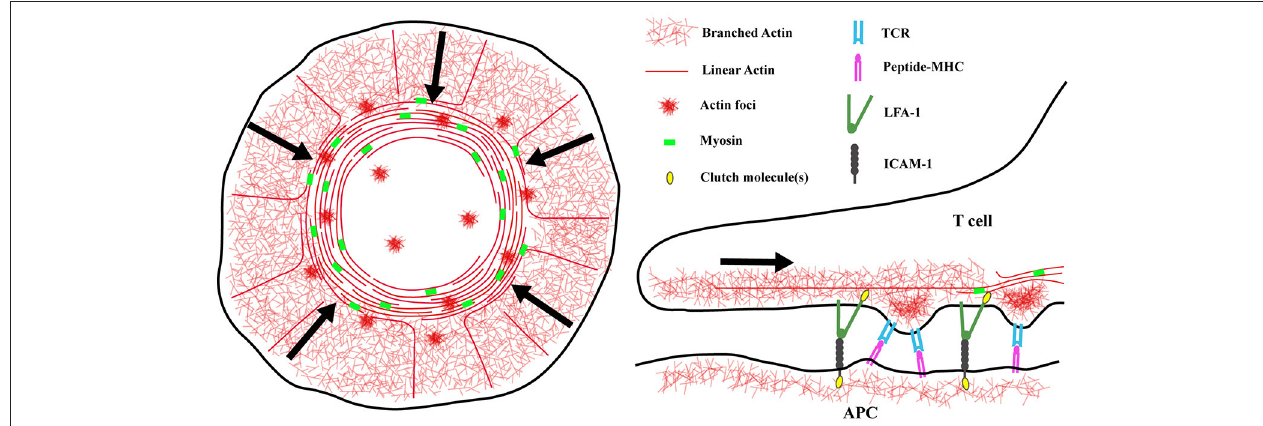
FIGURE 1 | Actin architecture at the immunological synapse. (Left) Diagram showing the distinct actin networks at the immunological synapse. The architecture of a spreading T cell can be divided into three zones, a peripheral region enriched in branched actin filaments corresponding to the lamellipodium of a migrating cell, an inner lamellar region containing acto-myosin arcs, and a central actin-poor region. At the synapse edge, WAVE2 and Arp2/3 complex direct the polymerization of branched actin filaments, pushing the network to flow inward. Also in this region, formins nucleate linear actin filaments that are then organized into concentric arcs by myosin activity. Lastly, WASp dependent actin “foci” appear at the synapse and co-localize with TCR microclusters. (Right) The different networks may have different functions at the IS. Actin foci are thought to protrude from the T cell into the APC membrane and facilitate TCR/peptide-MHC interactions. The rapidly flowing branched actin network, and to a lesser extent the slower moving actomyosin arcs, provide the force needed to separate the cytoplasmic tails of LFA-1 and transition it into the high affinity state. Actin arcs are also important for sweeping TCR microclusters inward and promoting T cell activation. Understanding the details of how these different networks transmit mechanical energy will have important implications for mechanosensing and mechanotransduction at the